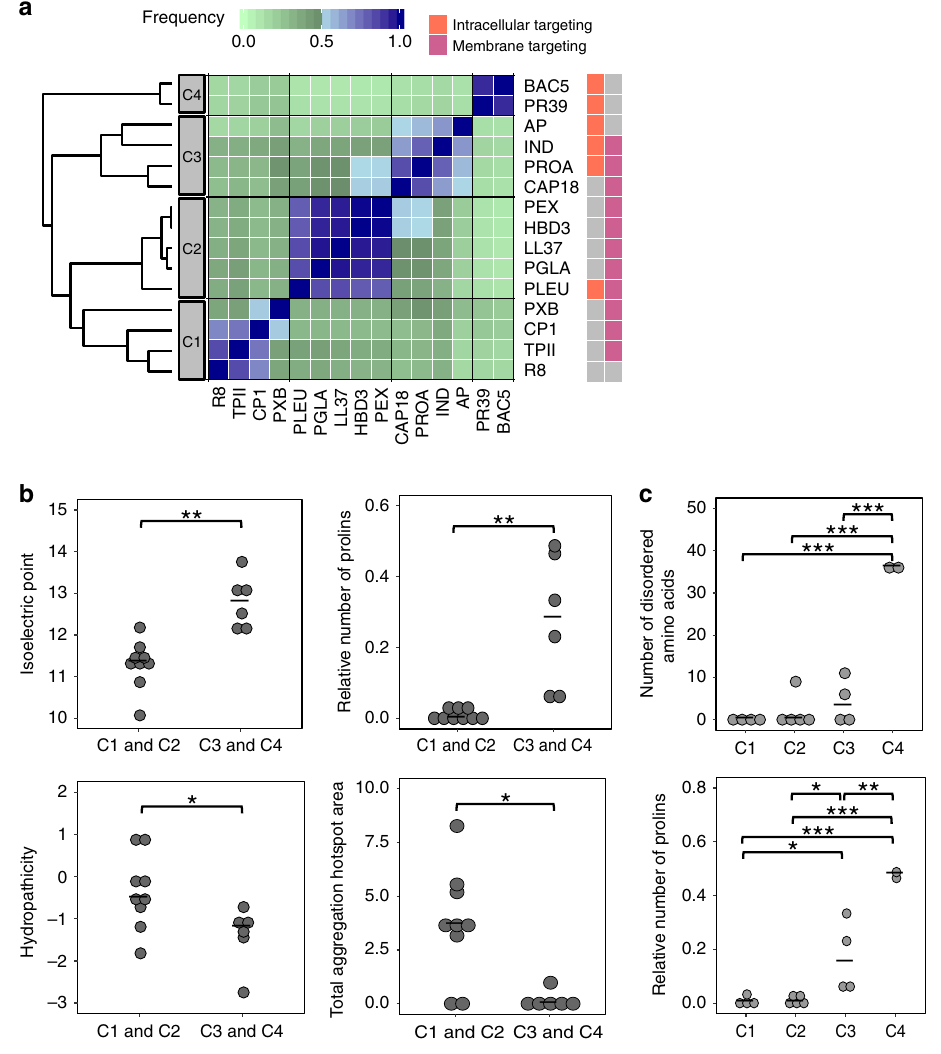
Fig. 2 Chemical-genetic pro fi ling discriminates membrane-targeting and intracellular-targeting AMPs. a Heatmap showing the ensemble clustering of the AMPs based on their chemical-genetic pro fi les (see Methods). For each AMP pair, the color code represents the frequency of being closest neighbors across the ensemble of clusters ( n = 75,000 clustering). The four major clusters are labeled as C1, C2, C3, and C4. Membrane-targeting and intracellular- targeting broad modes of action are labeled with pink and orange, respectively, on the rightmost side of the fi gure. Gray color indicates that the speci fi c broad mode of action has not been described or not tested (see Table 1). References describing these activities are provided in Supplementary Data 7. b Most important physicochemical properties that differentiated AMPs in cluster C1, C2 from AMPs in cluster C3, C4. Signi fi cant differences: ** P = 0.0026 and 0.0012 for isoelectric point and relative number of prolines, respectively, * P = 0.0391 and P = 0.0154 for hydropathicity and total aggregation hotspot area, respectively, two-sided Mann – Whitney U test, n = 9 and n = 6 for C1, C2 and C3, C4, respectively. c , Physicochemical properties that distinguished the clusters when the 4 main AMP clusters were considered separately ( p < 0.05 ANOVA, Tukey post-hoc test, n = 15). Signi fi cant differences: *** P = 1.1×10 – 6 , P = 1.3× 10 − 6 and P = 4 × 10 − 6 for C1 vs C4, C2 vs C4 and C3 vs C4, respectively in the case of number of disordered amino acids. * P = 0.034 and P = 0.027 for C1 vs C3 and C2 vs C3, respectively. ** P = 0.0022 for C3 vs C4. *** P = 5.5 × 10 − 5 and P = 4.2× 10 − 5 for C1 vs C4 and C2 vs C4, respectively, in the case of relative number of prolines. Central horizontal lines represent median values. Source data are provided as Supplementary Data